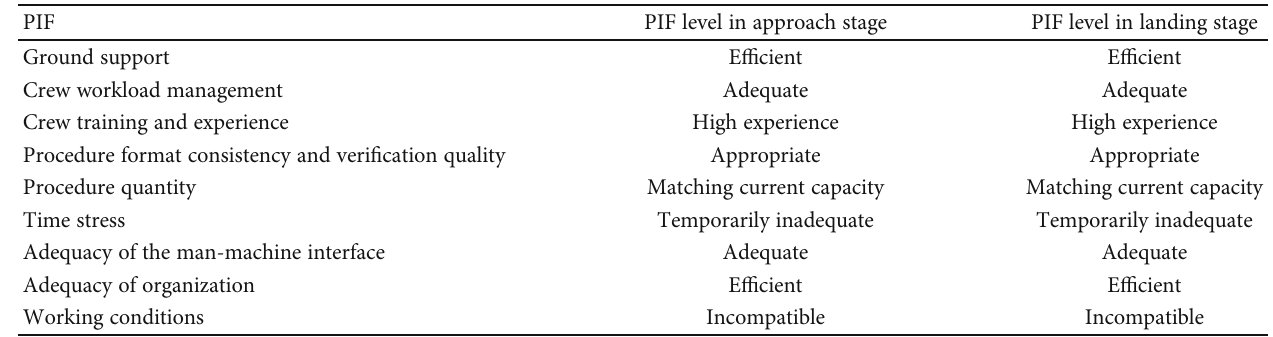
Table 7: PIF levels in the approach and landing stages.